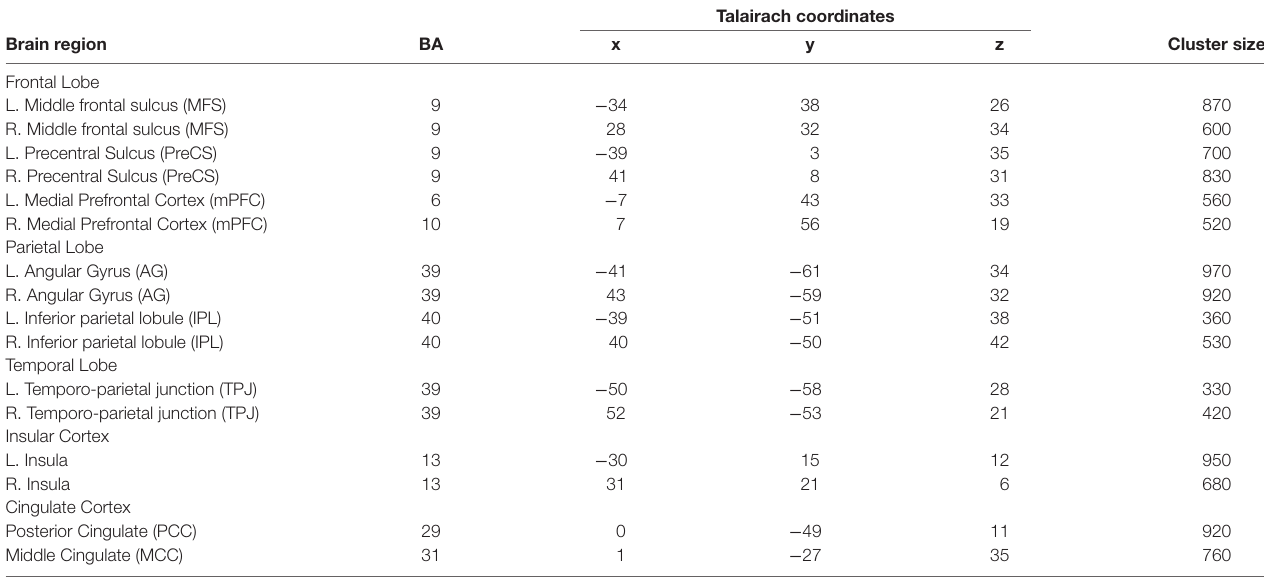
TABLE 3 | Talairach coordinates of the ROIs revealing significant differences in between-group